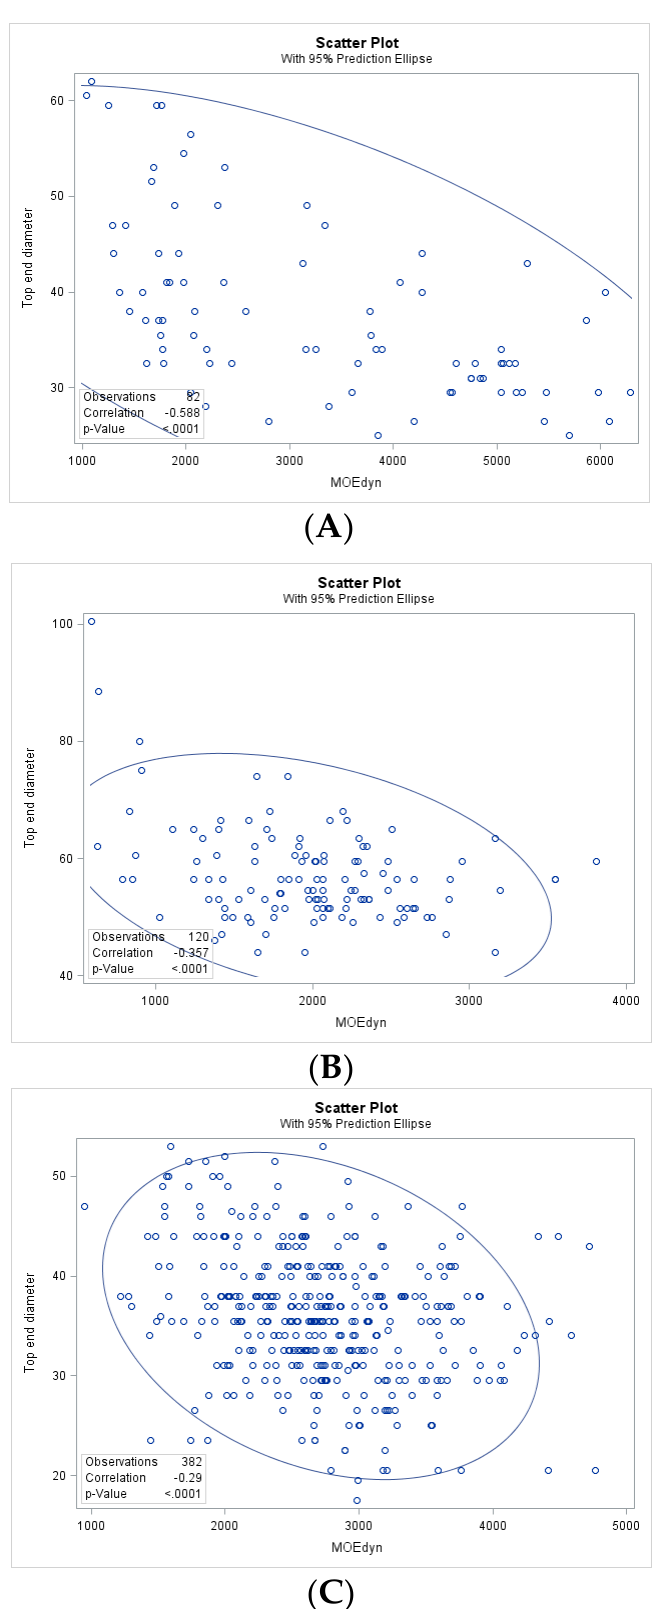
Figure 7. Correlation between top-end diameter (D top–end , cm) and dynamic modulus of elasticity (MOEdyn, N mm − 2 ) of small-leaved lime trees in different sites: ( A ) forest sites; ( B ) urban park; ( C ) along streets.